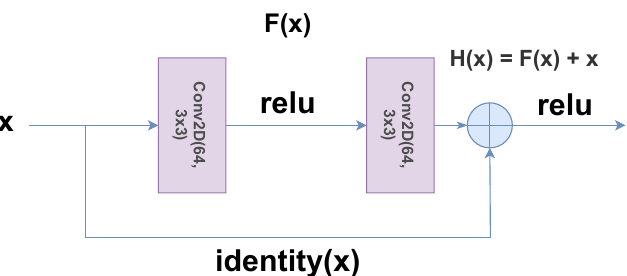
Figure 3. A schematic diagram of the skip connections in the ResNet architecture. (He et al. [22]).